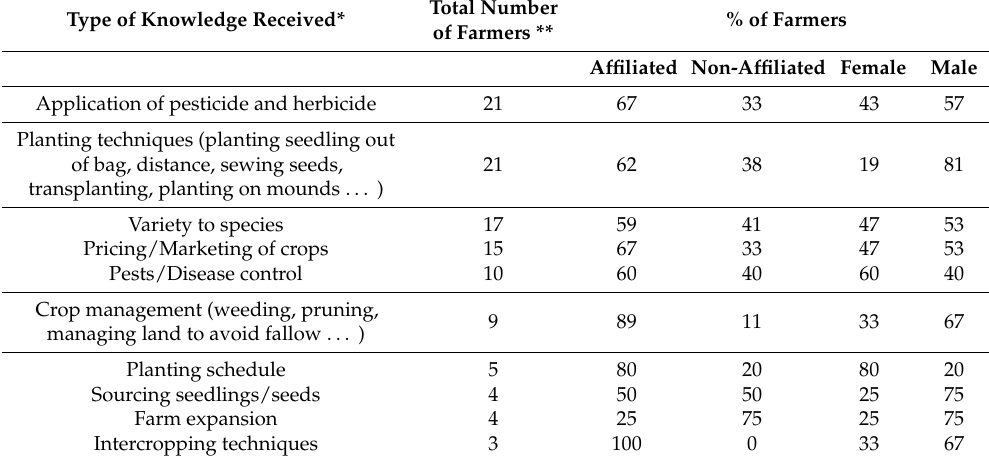
Table 4. Types of knowledge received by farmers across affiliation and by